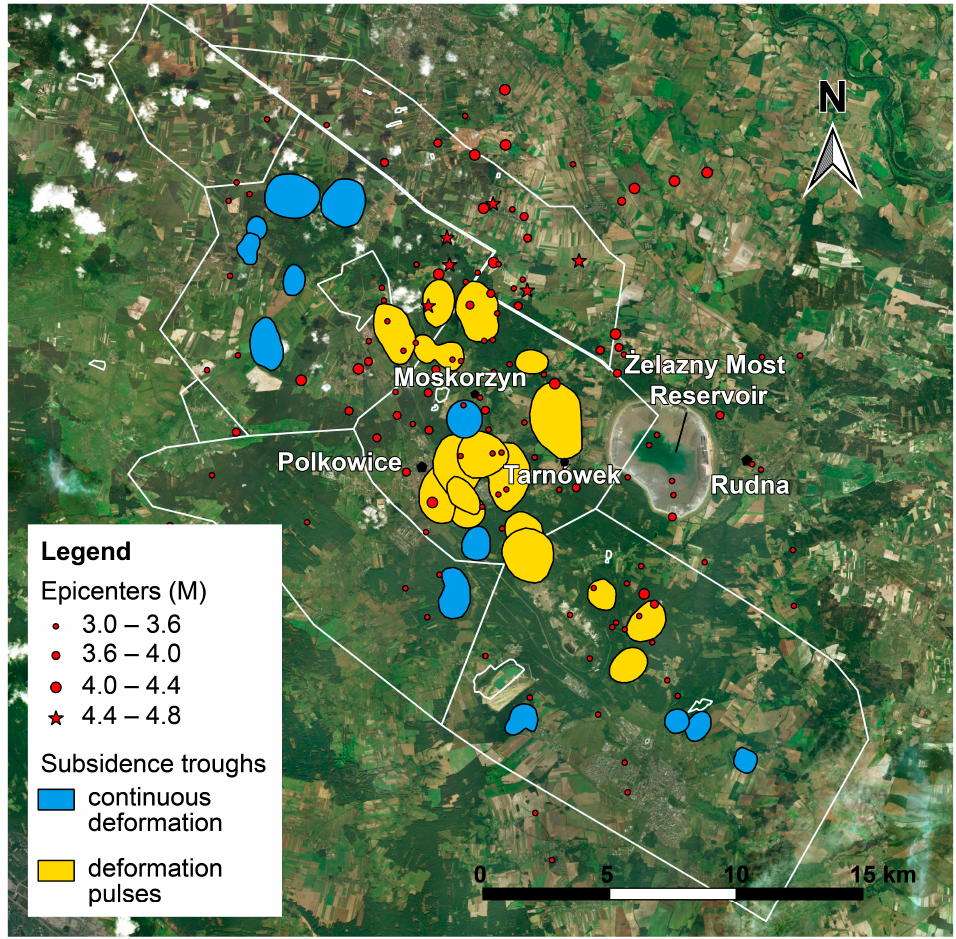
Figure 10. Epicenters distribution of seismic events with a magnitude > 3.0 that occurred between October 2014 and April 2019, and distribution of the subsidence troughs (epicenters from https://www.emsc.eu/, accessed on 10 February 2021).